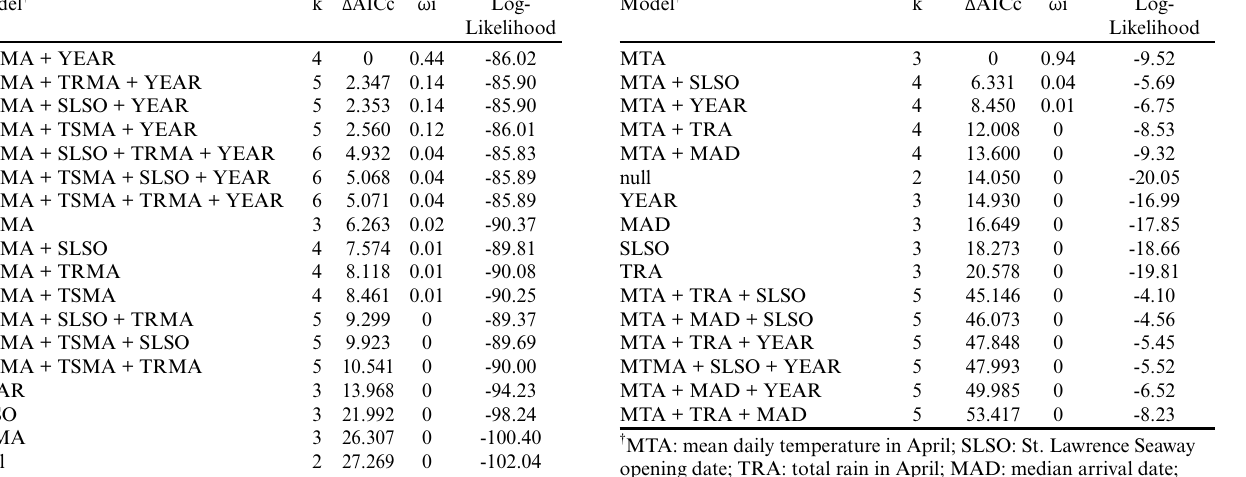
Table 2 . Ranking of models explaining variation in the median laying date of Ring-billed Gulls ( Larus delawarensis ) at Île de Likelihood